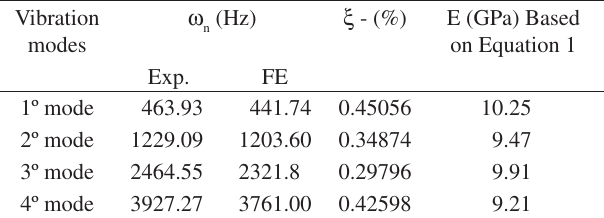
Table 3. Dynamical characteristics estimated for the ATJ graphite beam.